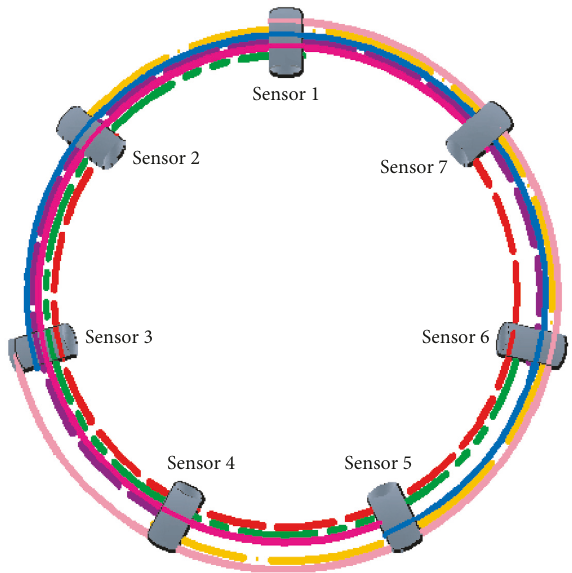
Figure 3: Example for the combination process of analytical so- lutions. Every 6 triggered sensors can constitute a set of sensor networks, and 7 kinds of networks are represented by curves with different colors (from